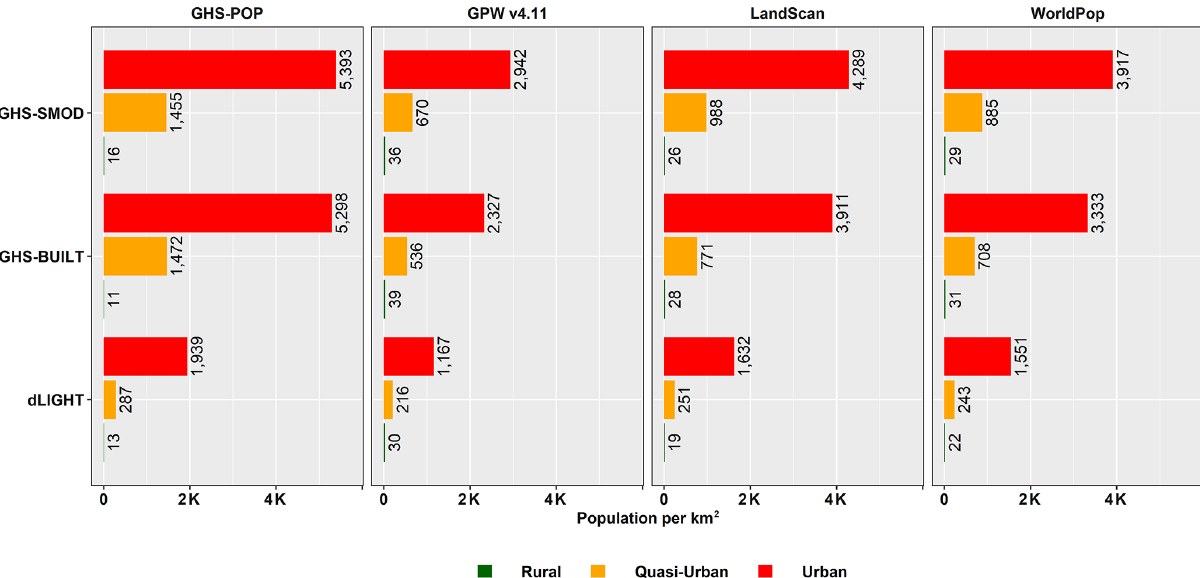
Figure 15. Population density of urban, quasi-urban and rural areas by urban-proxy data sets ( y axis) and population data ( x